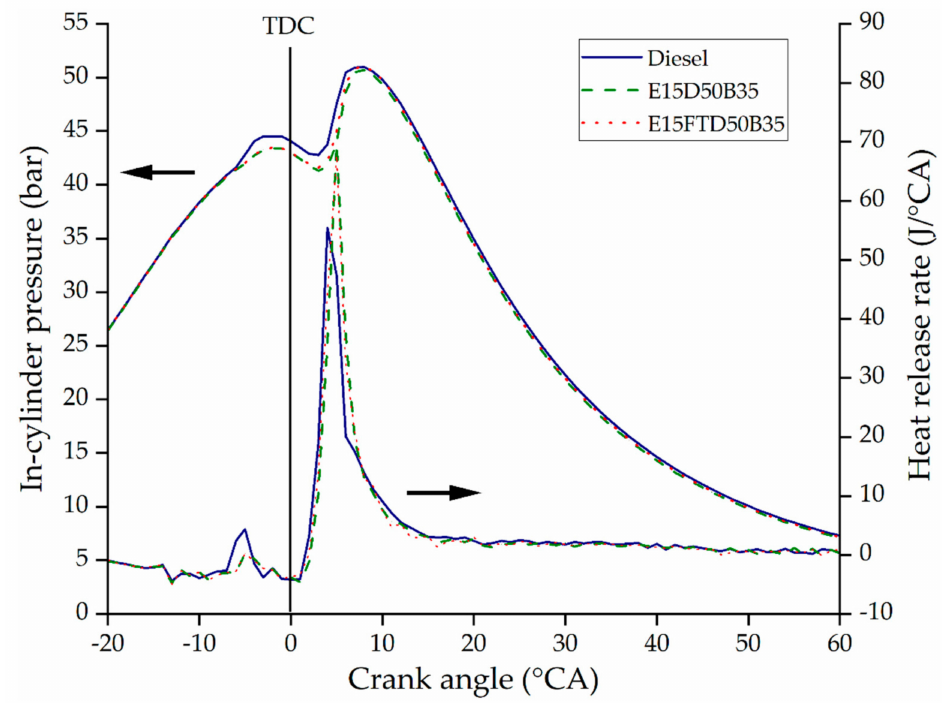
Figure 3. Effect of different fuel combustion on in-cylinder and heat release rate with a crank angle at 2 bar indicated mean effective pressure (IMEP) and 1500